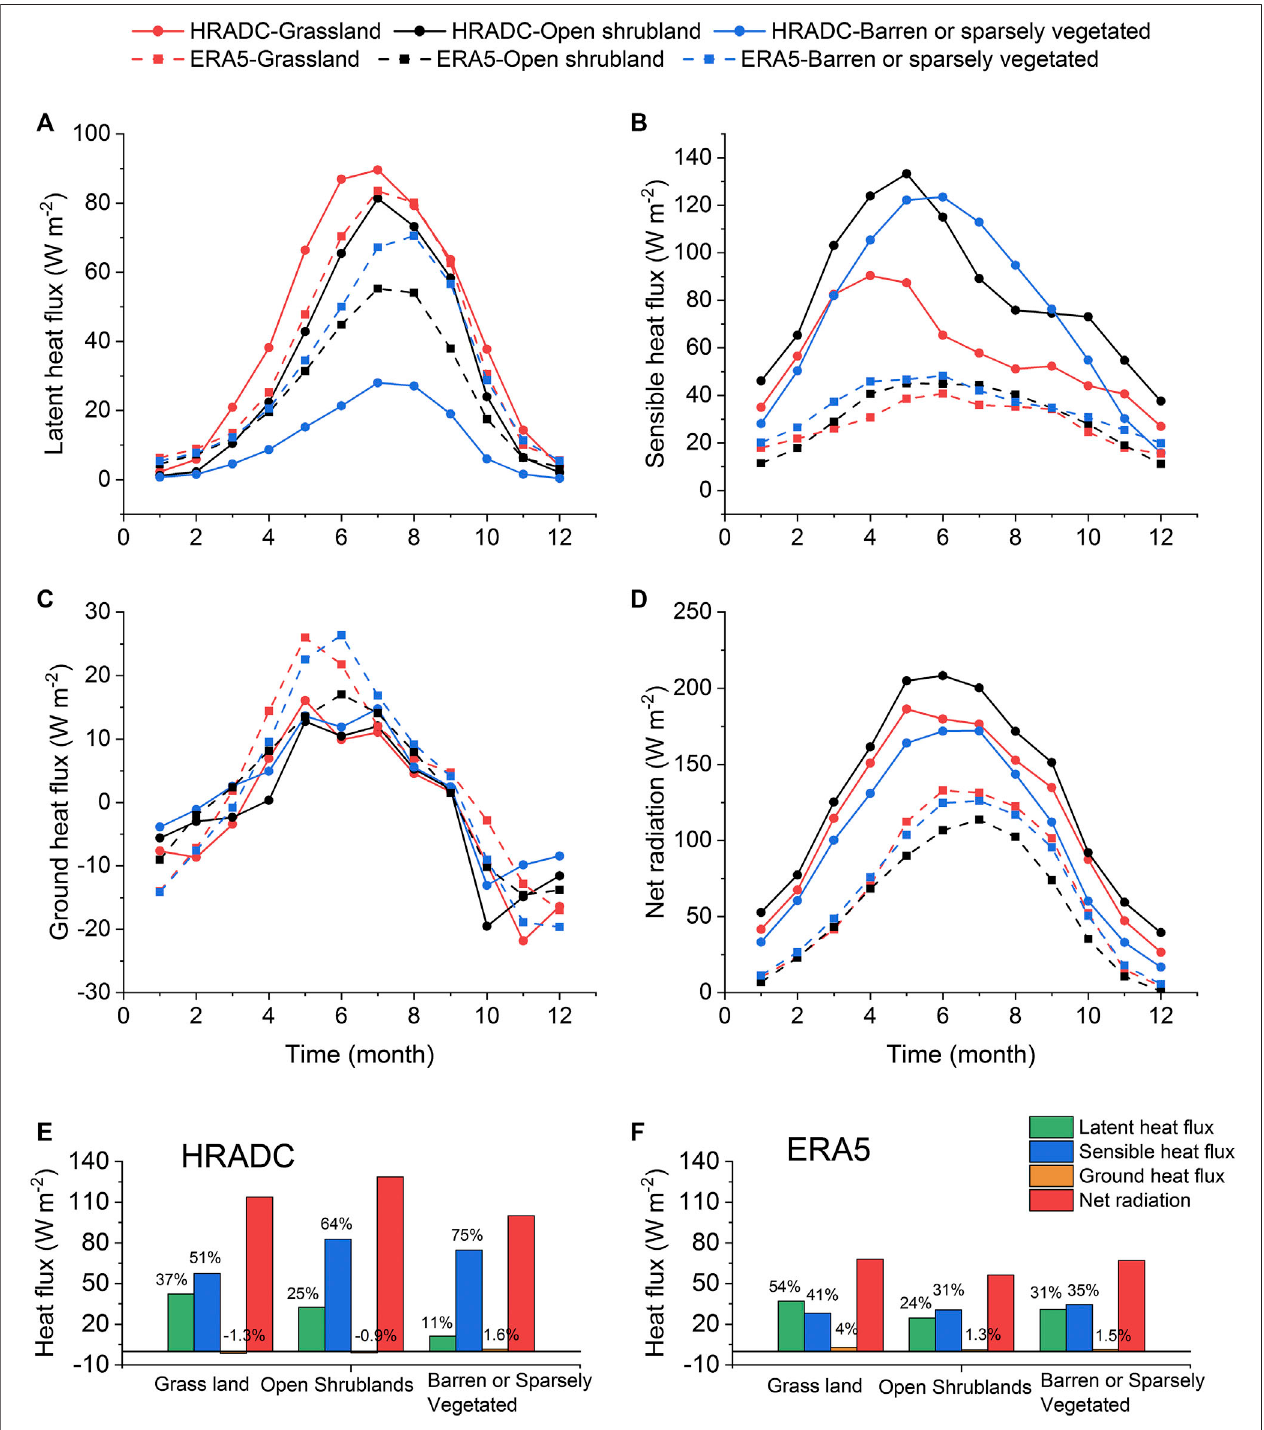
FIGURE 9 | The comparison of surface energy fl ux and net radiation between High-Resolution Assimilation Dataset of the Water-Energy Cycle in China and ERA5 over Grassland (red line), Open shrubland (black line), and Barren or sparsely vegetated (blue line) in the Qinghai-Tibet Plateau (Unit: W · m − 2 ). (A) latent heat fl ux, (B) sensible heat fl ux, (C) ground heat fl ux, (D) net radiation, and the histogram of energy distribution proportion (E,F) .